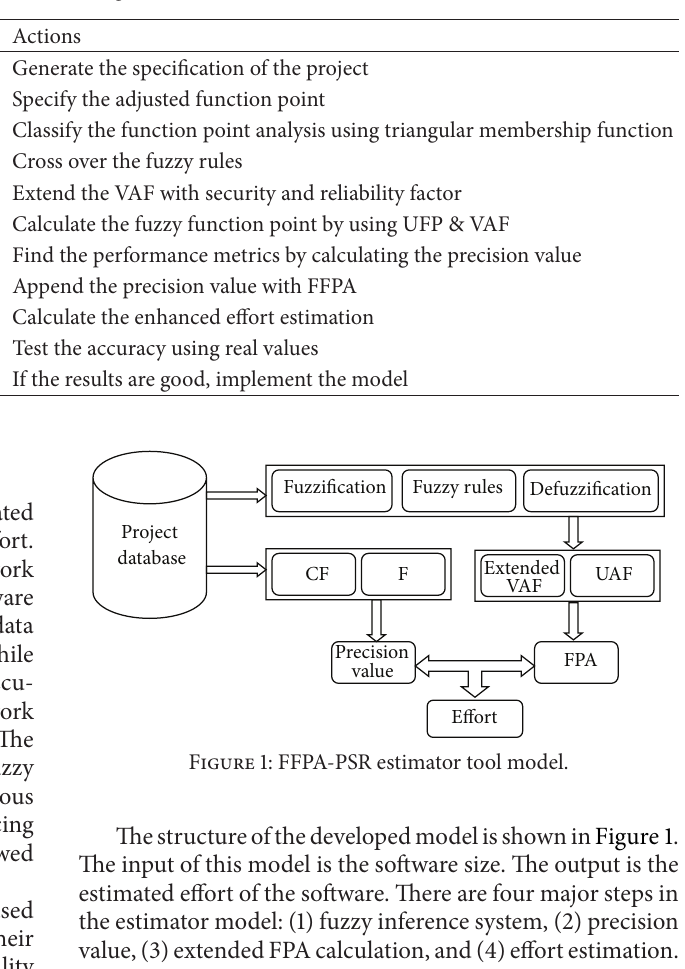
Table 1: FFPA-PSR algorithm.